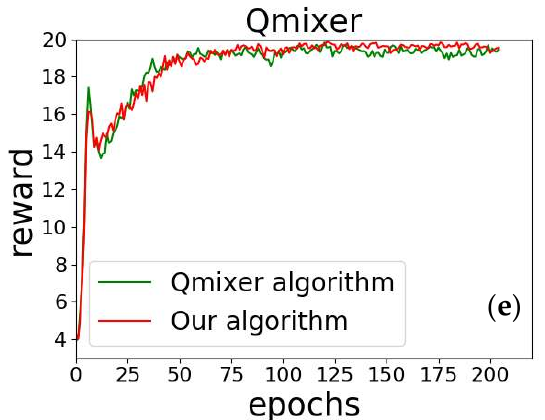
Figure 2. Comparison chart of training process. Our algorithms are compared in COMA algorithm ( a ), QTRAN algorithm ( b ), VDN algorithm ( c ), IQL algorithm ( d ) and Qmixer algorithm ( e ).